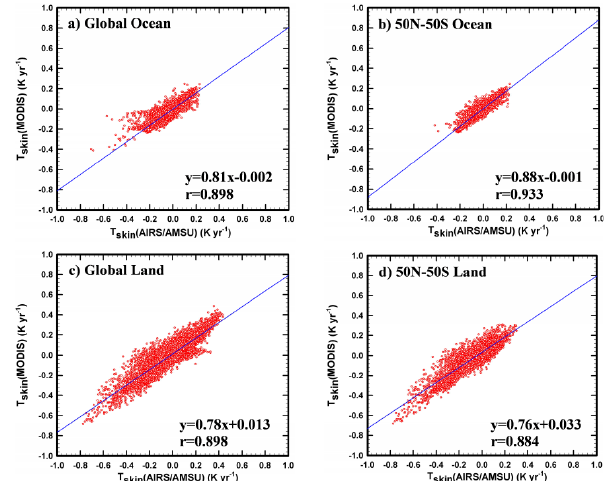
Fig. 7. Scatter diagrams in the monthly temperature anomaly trends (Kyr − 1 ) of T skin (MODIS) versus T skin (AIRS/AMSU) over the re- gions of (a) global ocean, (b) the 50 ◦ N–50 ◦ S ocean, (c) global land, and (d) the 50 ◦ N–50 ◦ S Land. The values of AIRS/AMSU and MODIS have been compared with each other in a grid box of 1 ◦ × 1 ◦